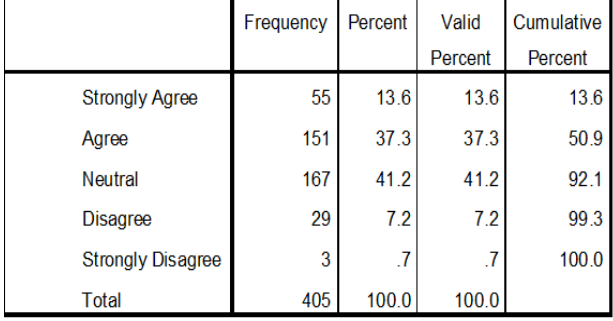
Figure 7. The stock value of the company in on the upward slope from the time of cloud and IoT